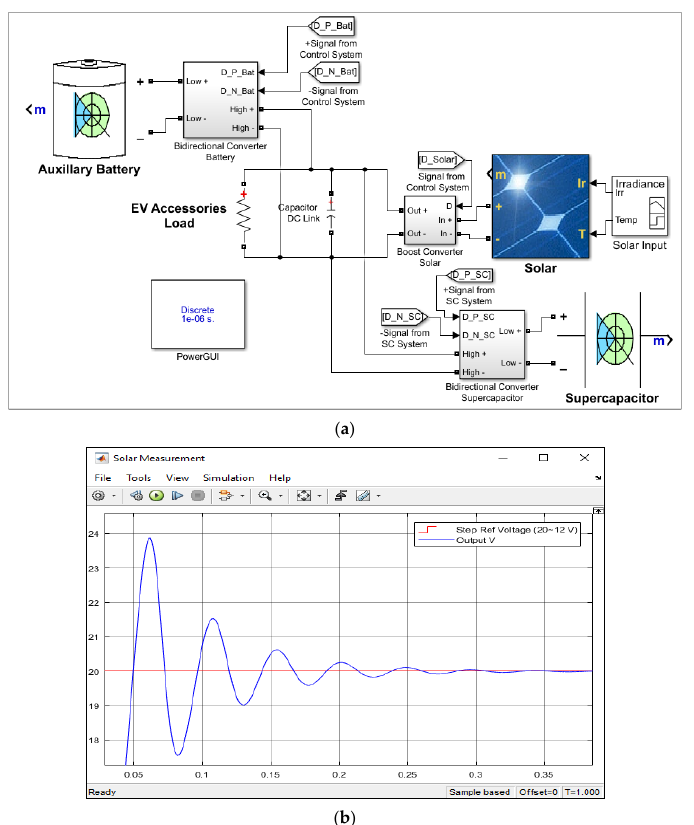
Figure 3. ANFIS model ( a ) system architecture and ( b ) output voltage profile of solar panel without controller at 1000 W/m 2 .